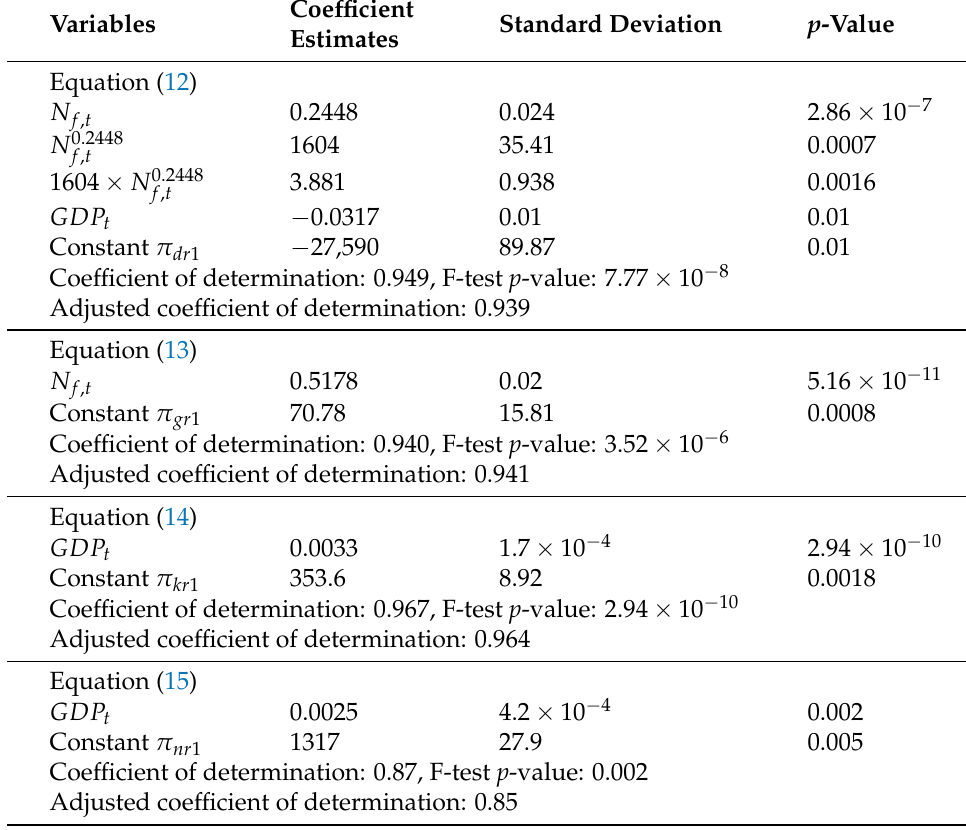
Table 5. The estimated parameters of the petroleum refining subsystem. Coefficient Variables Standard Deviation p Estimates